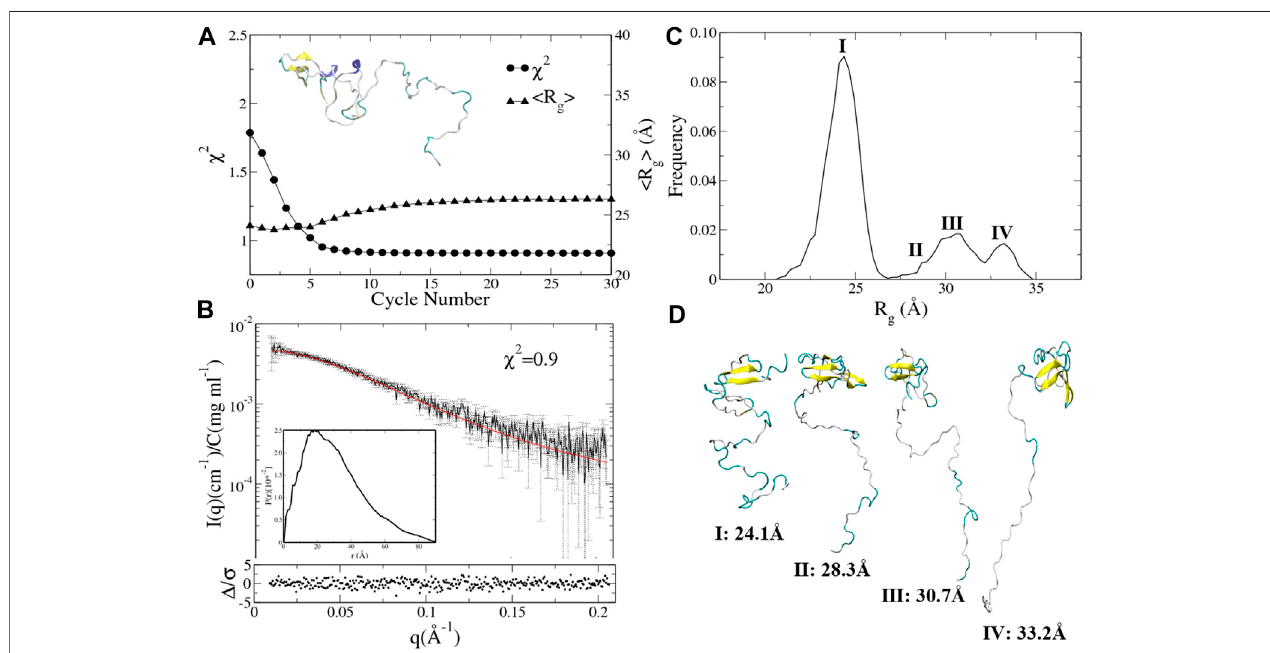
FIGURE6| IntegrativemodelingfromarelativelycompactstructureofUL11. (A) Theminimal χ 2 (circle)andthecorresponding < R g > (up-triangle)ateachcycle.The inset is the starting structure. (B) The back-calculated SAXS pro fi le of the selected ensemble (red line) is fi tted to the experimental data (black line with errors). The lower plot shows the error-weighted residual of the model fi tting. The inset is the ensemble-averaged PDDF. (C) Distribution of R g values calculated from the ensembles after the 11th cycle. (D) Representative structures according to the R g distribution.